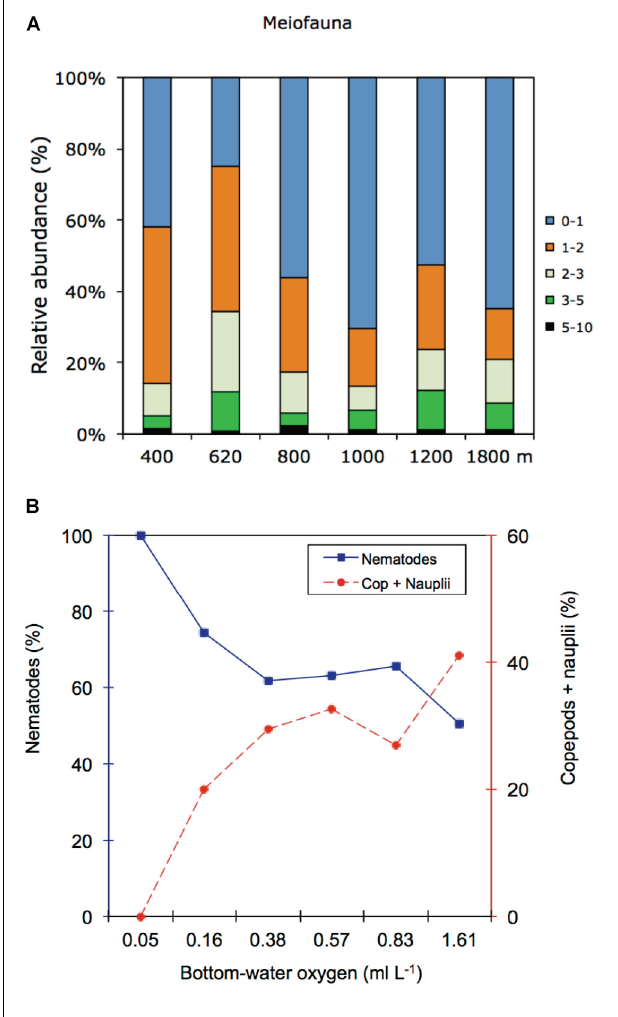
FIGURE 9 | (A) Relative abundance (%) of meiofauna per sediment layer at each study site. (B) Relative abundances (%) distribution of nematode and copepods + nauplii for the upper 1 cm sediment along the bottom-water oxygen